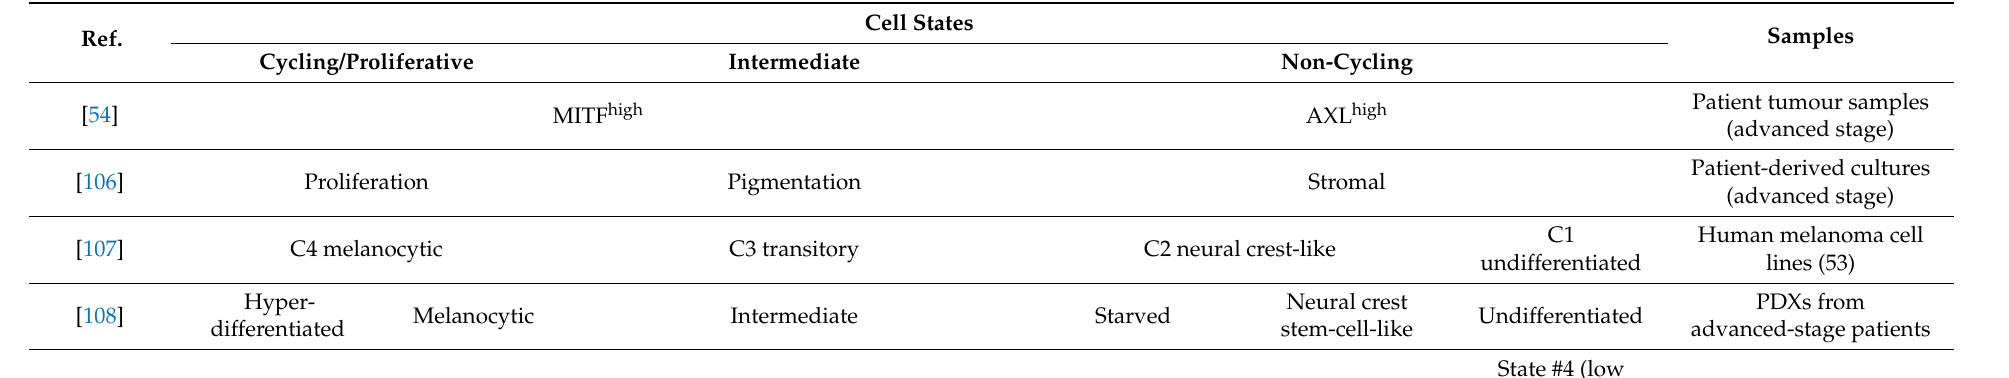
Table 2. Different cell states proposed in different